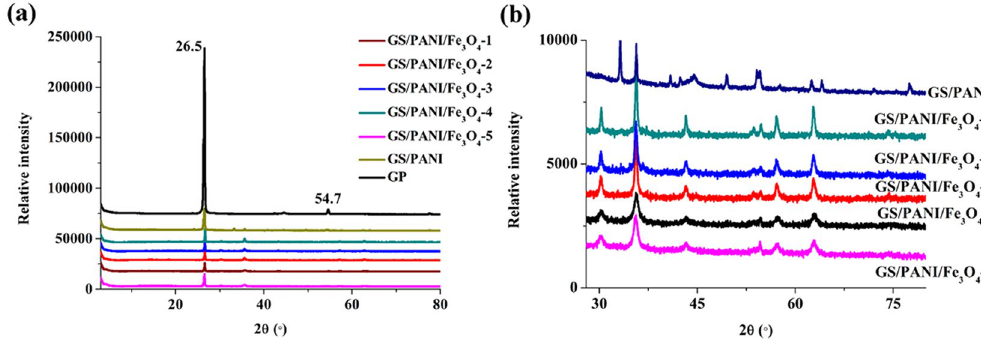
Figure 2. XRD patterns of GP, GS/PANI and GS/PANI/Fe 3 O 4